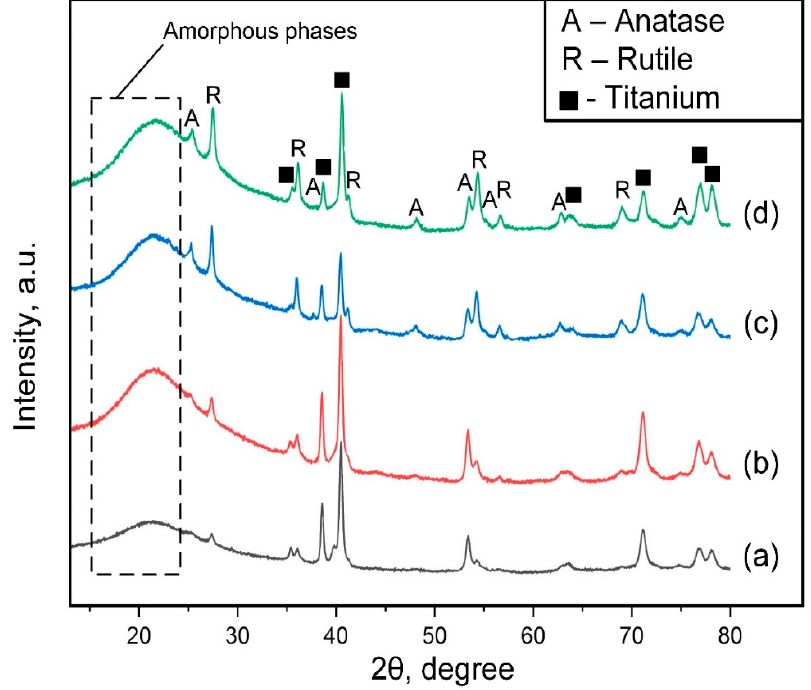
Figure 6. X-ray diffraction patterns of the 0GO ( a ), 0.1GO ( b ), 0.3GO ( c ), and 0.5GO ( d ) after MAO treatment. MAO